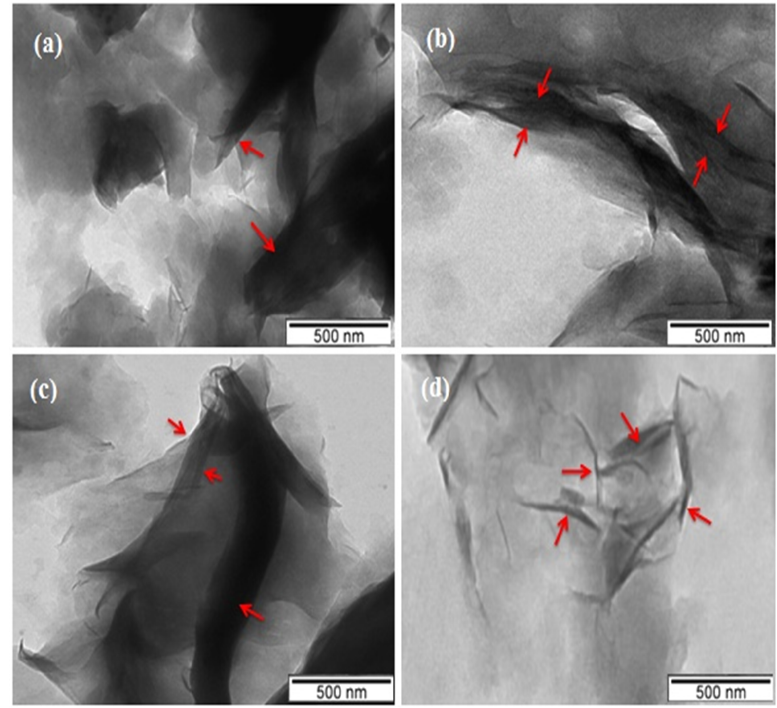
Figure 6. TEM images of Mag-CTA + ( a ), Ros-Lim / Mag-CTA + 10% ( b ), Ros-Lim / Mag-CTA + 5% ( c ) and Ros-Lim / Mag-CTA + 1% ( d ).